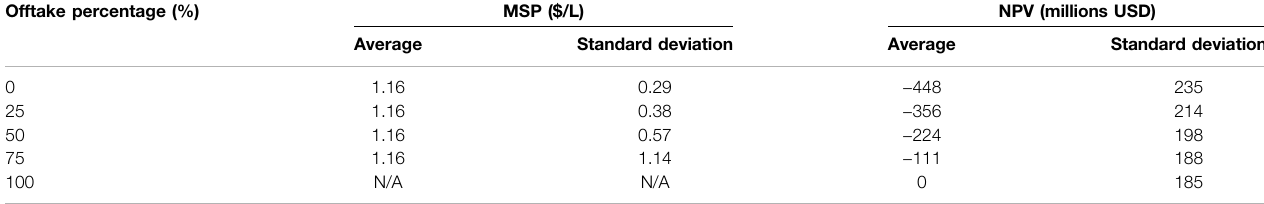
TABLE 4 | Changes in NPV and MSP values and standard deviations due to offtake agreements. Offtake percentage (%)